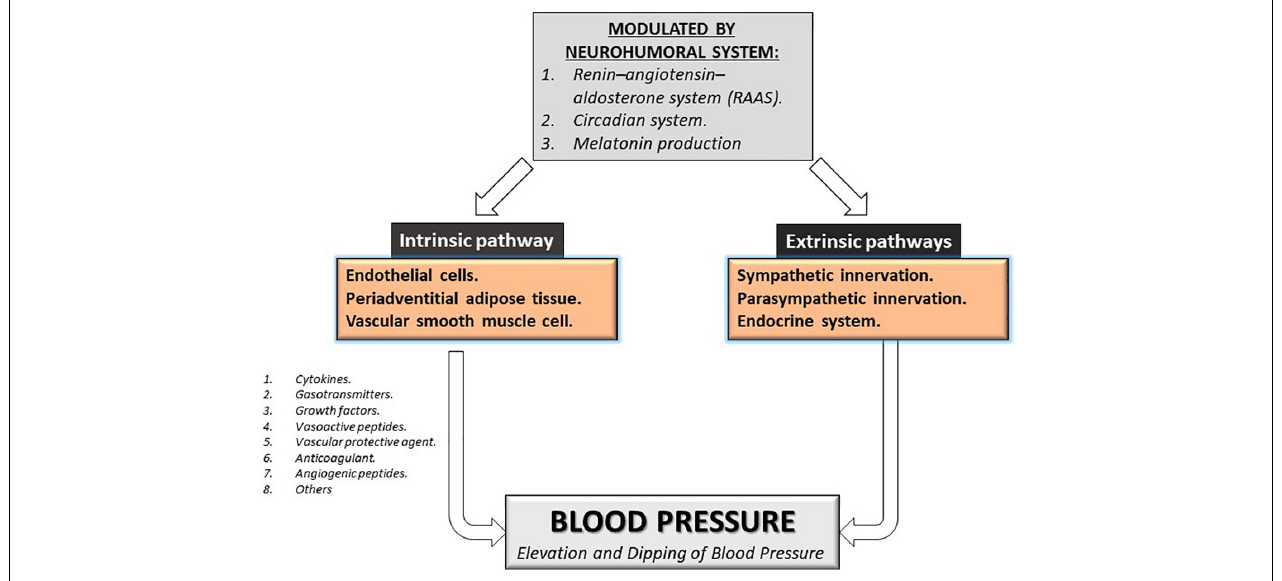
FIGURE 1 | Modulation of blood pressure. Intrinsic and extrinsic pathways can modulate blood pressure. The principal regulator of both pathways is the neurohumoral system Renin-Angiotensin-aldosterone system, the circadian system, and melatonin production.